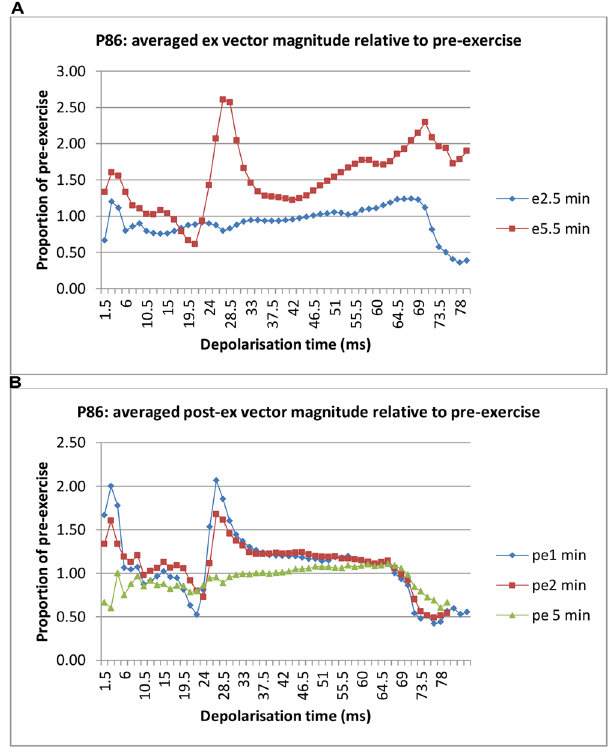
Figure 4. Changes in vector magnitude in the course of ventricular depolarisation. Panel A shows marked enhancement of RVM at 5.5 min of exercise occurring abruptly at 22.5 ms of depolarisation overriding the trend of reduction. Panel B shows resolution at 5 min post exercise (pe). The references for RVM during and after exercise were the lead signals while standing pre-exercise and sitting post-exercise, respectively.